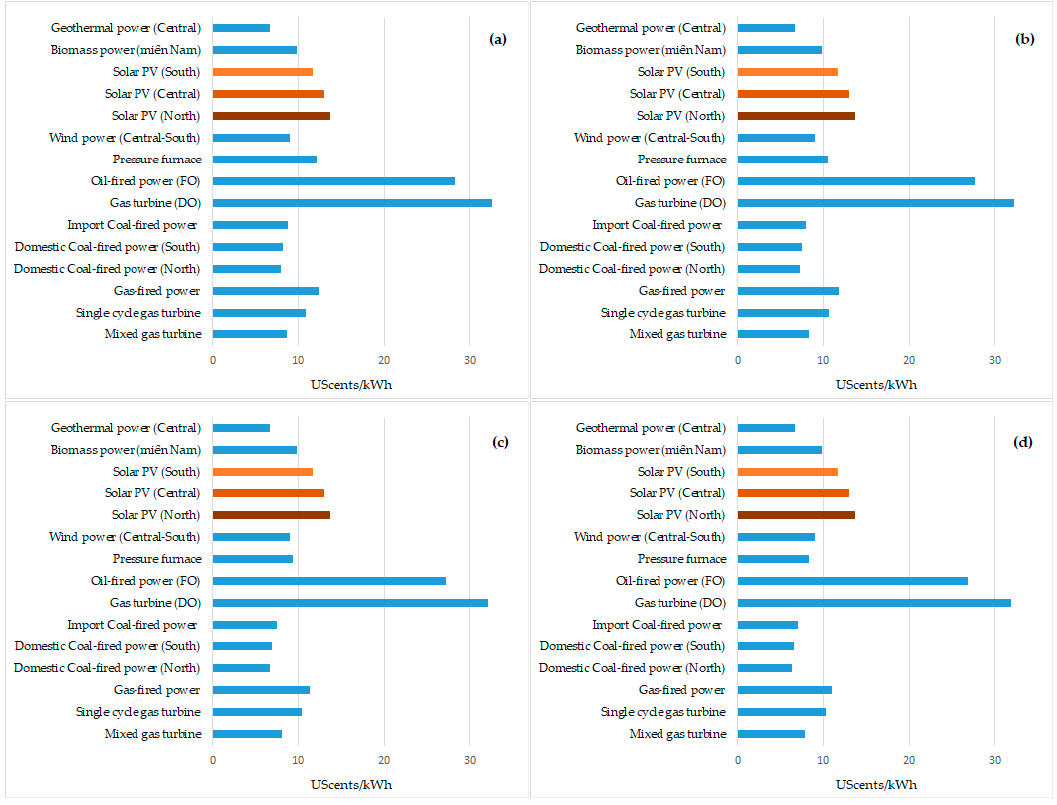
Figure 19. LCOE of power plants operated in 2020 with capacity factors of 60% ( a ), 70% ( b ), 80%, ( c ) and 90% ( d ) for fossil fuel plants